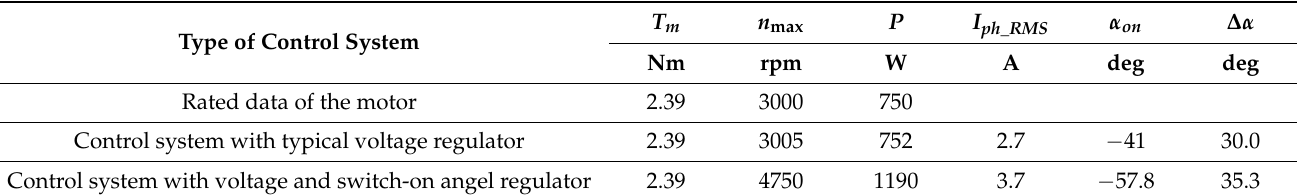
Table 5. Motor rated data and results of simulations of the drives with a typical voltage regulator and the proposed voltage and switch-on angle